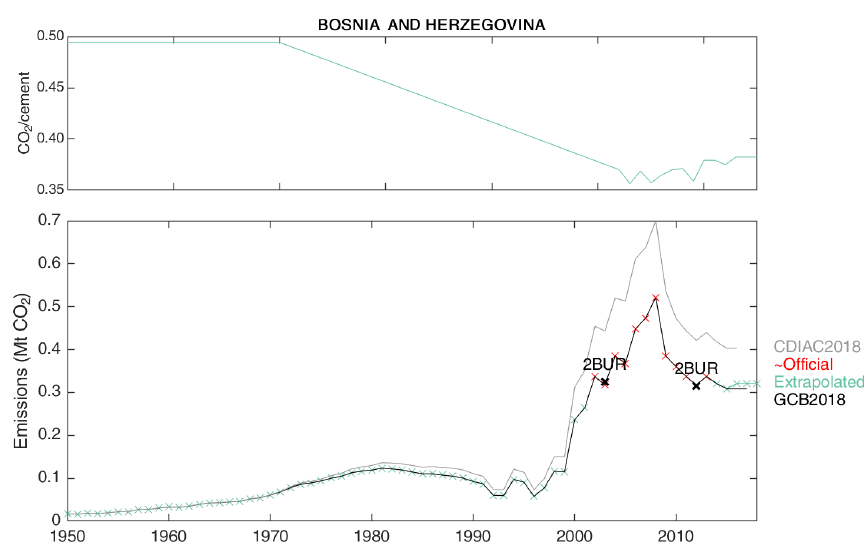
Figure C14. Revised cement emissions in Bosnia and Herzegovina.